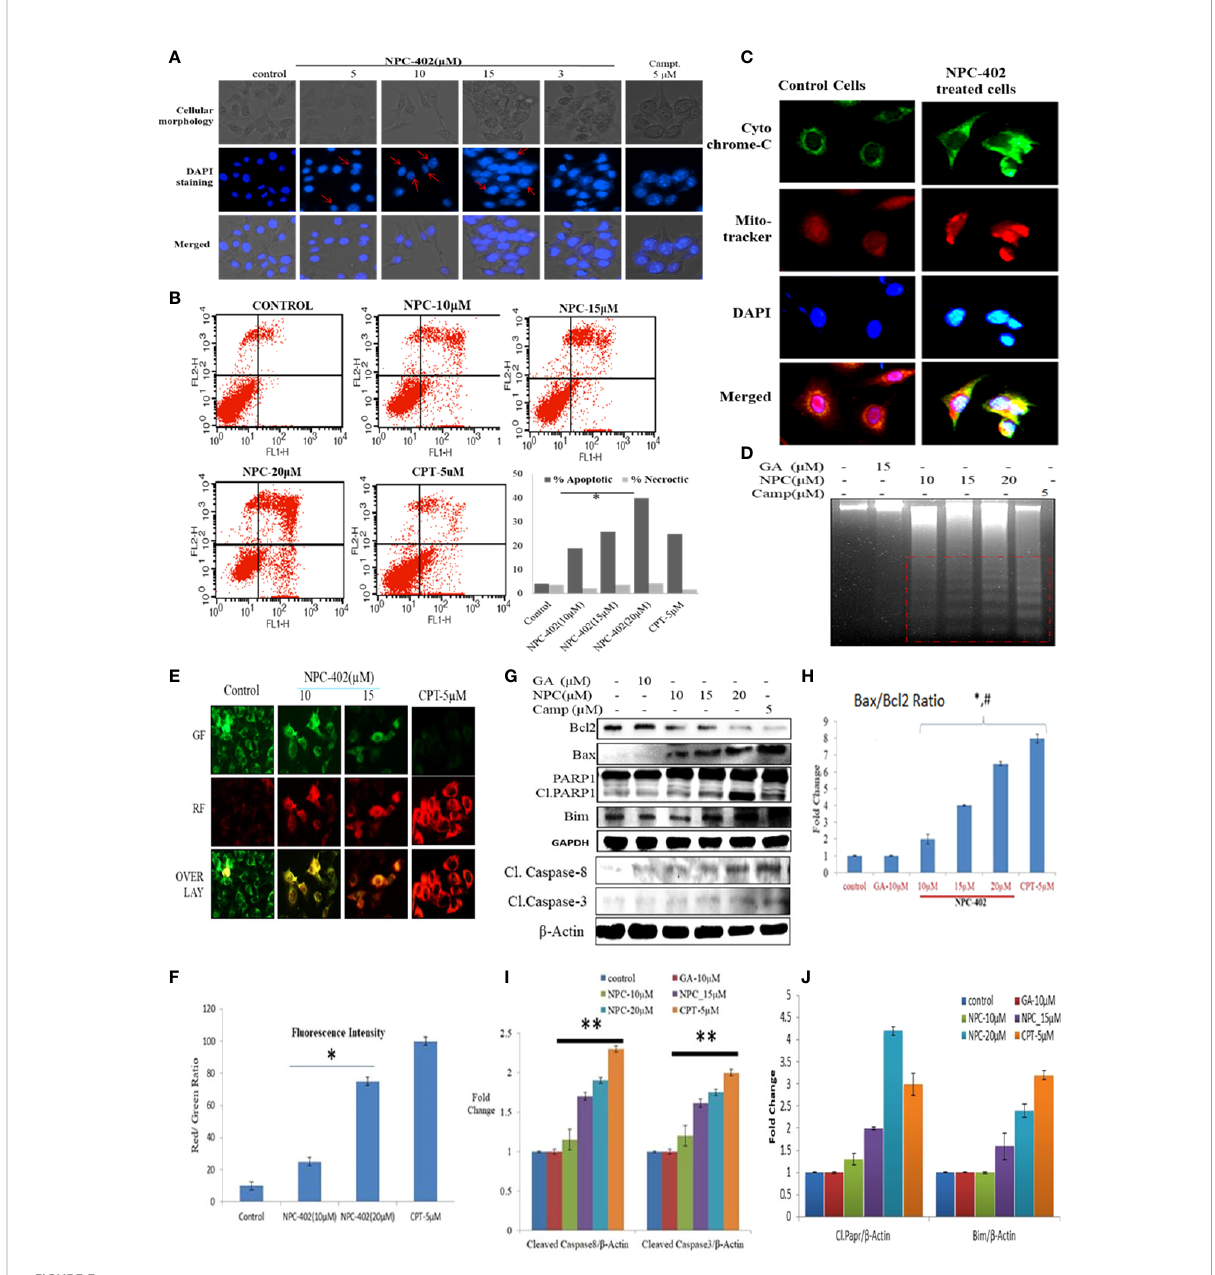
FIGURE 3 NPC-402 induces mitochondrial dysfunction and modulates the expression level of proapoptotic and antiapoptotic markers. (A) Staining of B16F10 cells with DAPI on treatment with NPC-402. Cellular morphology and nuclear fragmentation, indicated by red arrows, were seen in melanoma cell line post 24 h treatment, and camptothecin was used as a positive control. (B) Annexin V/PI FITC staining of B16F10 cells was done to fi nd the apoptosis induction in B16F10 cells post 12 h treatment of NPC-402 and found increasing percentages of Annexin-V-bound cells. (C) Represents the confocal imaging for the detection of cytochrome C translation into cytosol upon exposure of B16F10 cells to NPC-402 treatment for 12 h compared with untreated cells. (D) Gel diagram represents DNA fragmentation in B16F10 cells treated with/without NPC-402 for 24 h, camptothecin as a positive control, and GA as a parent molecule of NPC-402. (E) Microscopic images represent the JC-9 staining for the detection of DY m in B16F10 cells treated with/without NPC-402; CPT acts as a positive control. (F) Red/green fl uorescences of panel (B) were quanti fi ed by using ImageJ software (*p < 0.001; control vs. NPC-402 treatment). (G) Represents the Western blots of Bcl2, Bax, Parp1, Bim, caspase-8, and caspase-3 in B16F10 cells treated with NPC-402 for 24 h. b -Actin was used as a loading control. (H) Bar graphs represent the densitometry analysis of Bax/Bcl 2 ratio in B16F10 cells treated with NPC-402 for 24 h using Image Lab ™ Software Version 3.0 (Bio-Rad). (I) Bar graphs represent the densitometry analysis of cleaved caspase-8 and cleaved caspase-3 in B16F10 cells treated with NPC-402 for 24 h using Image Lab ™ Software Version 3.0 (Bio-Rad). ( J ) Bar graphs represent the densitometry analysis of cleaved PARP1 and Bim in B16F10 cells treated with NPC-402 for 24 h (* p < 0.001, control vs. NPC-402 treatment; ** p < 0.01, control vs. NPC-402 treatment; p<0.05 GA treated vs.